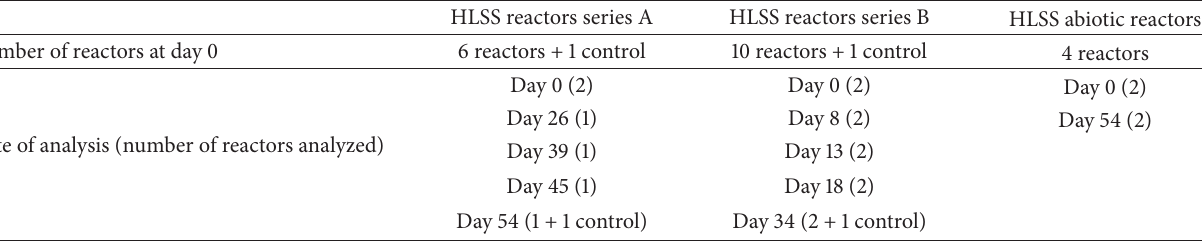
Table 1: Batch experiment setup. HLSS reactors series A and B with their respective nonspiked control HLSS reactors and the abiotic